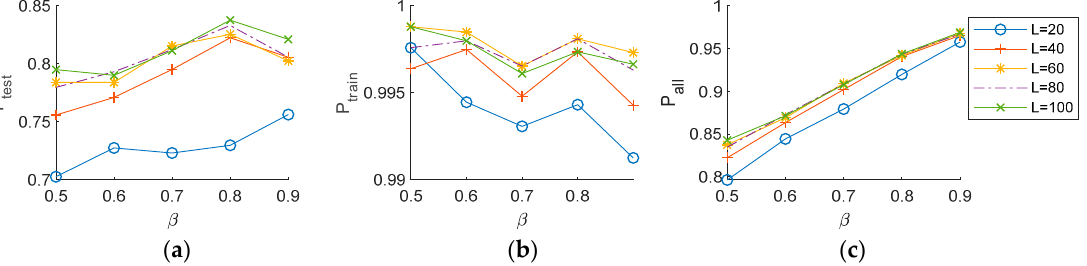
Figure 8. The curve of overall accuracy changing with the training images ratio β at different image size. ( a ) The accuracy of the test set; ( b ) The accuracy of the training set; and, ( c ) The accuracy of all images.